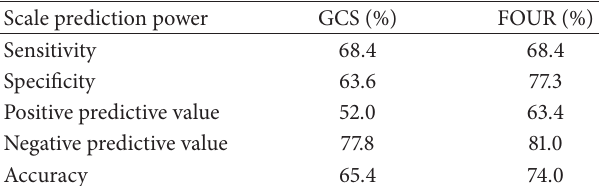
Table 2: Diagnostic values of GCS and FOUR for prediction of